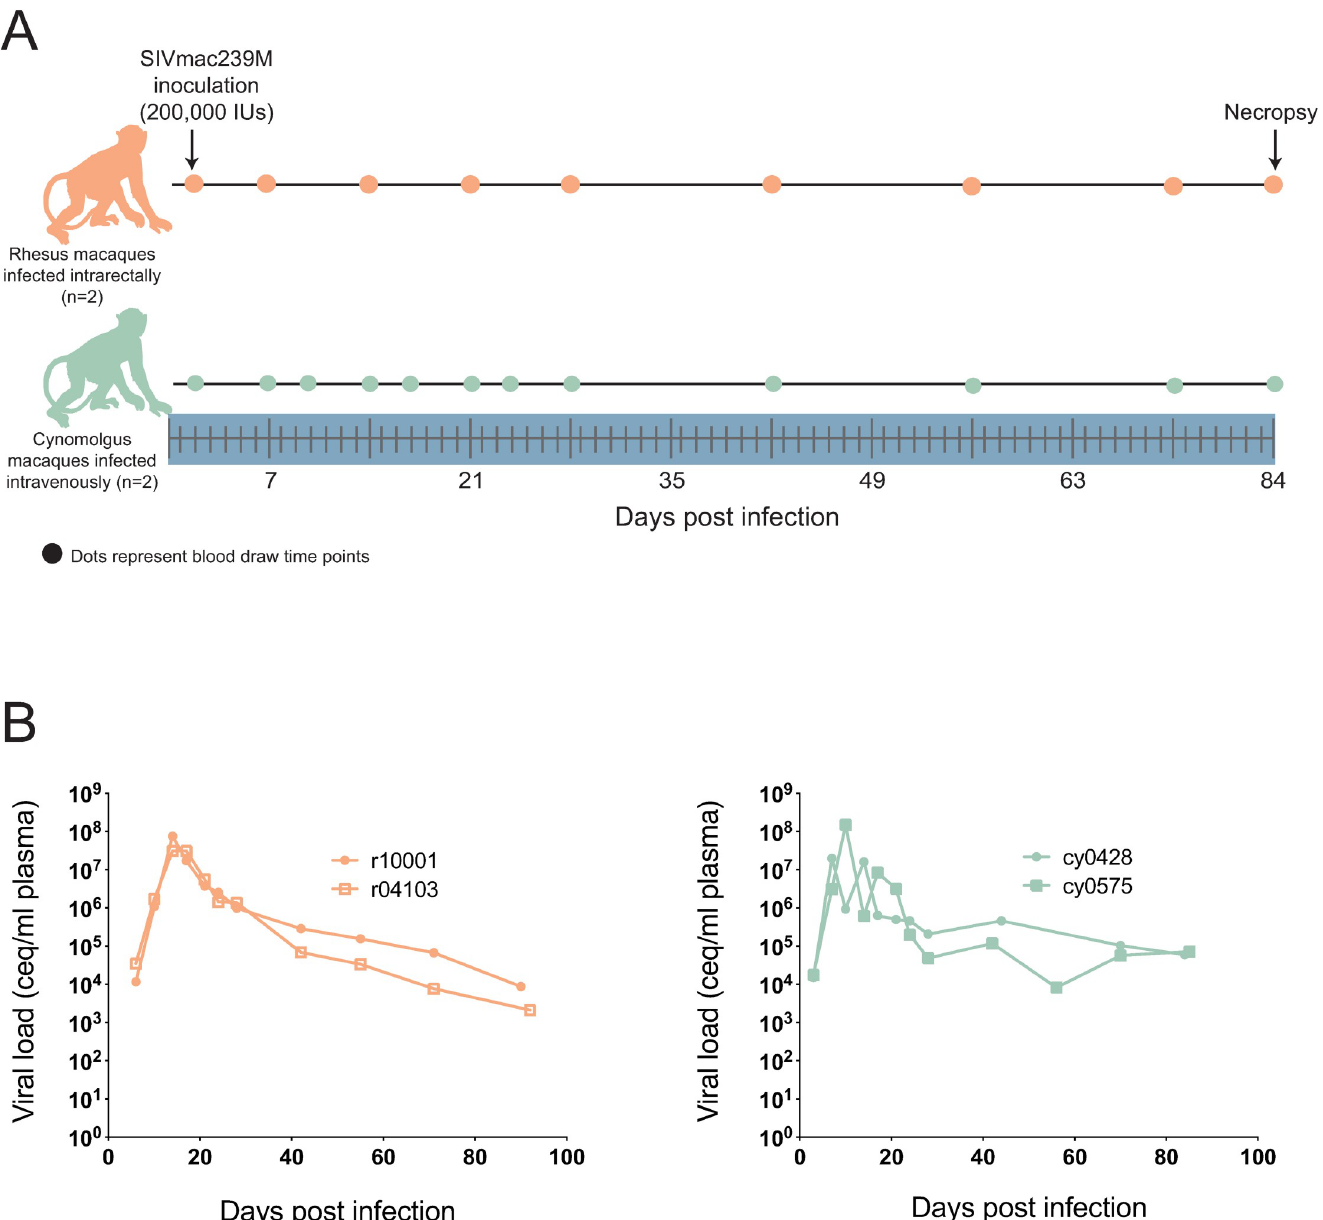
Fig 1. Study timeline and viral loads. A) Two Mamu-A1 � 001+ rhesus macaques were inoculated intrarectally (IR), and two Mafa-A1 � 063+ cynomolgus macaques were inoculated intravenously (IV), with 200,000 Infectious Units (IU) of SIVmac239M. Whole blood was drawn at the time points indicated. B) Viral loads in both groups of animals were calculated by qRT-PCR from